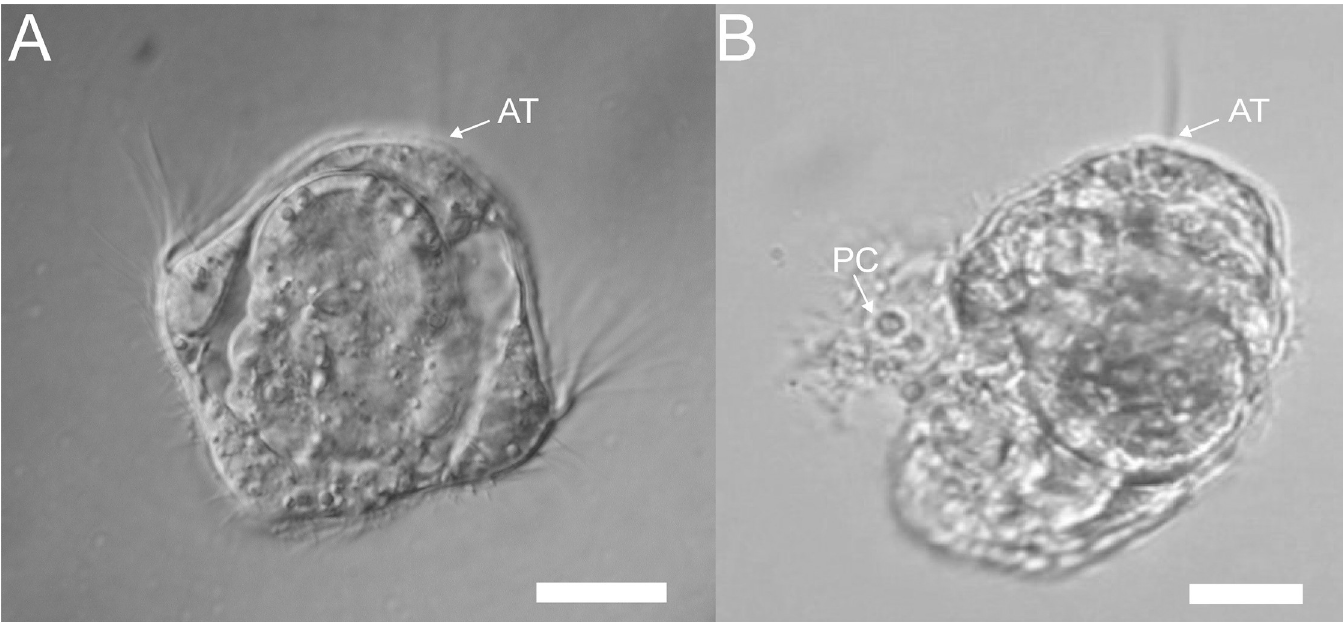
Fig 5. Pre-competent larvae of H . elegans lose cilia and prototroch cells when exposed to the semi-purified tailocin arrays from P . luteoviolacea . (A) Untreated pre- competent trochophore larva of H . elegans . (B) Treated pre-competent larvae of H . elegans showing loss of prototroch cells and cilia. AT, apical tuft of cilia; PC, prototroch cells detaching from the larva. Scale bar: 20 μ m.